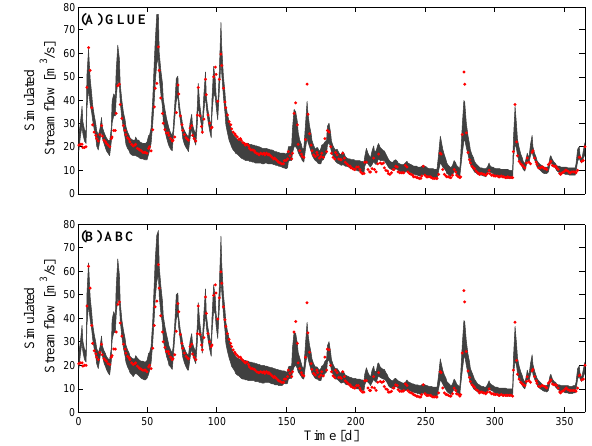
Fig. 11. Hmodel derived 95% streamflow simulation uncertainty ranges (grey region) of the calibration period of the French Broad river basin using (A) GLUE and (B) ABC. The observed discharge data are indicated with the solid red dots. We limit our display to the first 365 days of the calibration data set to facilitate graphical in- terpretation. The uncertainty ranges appear very similar and nicely cover the observed discharge